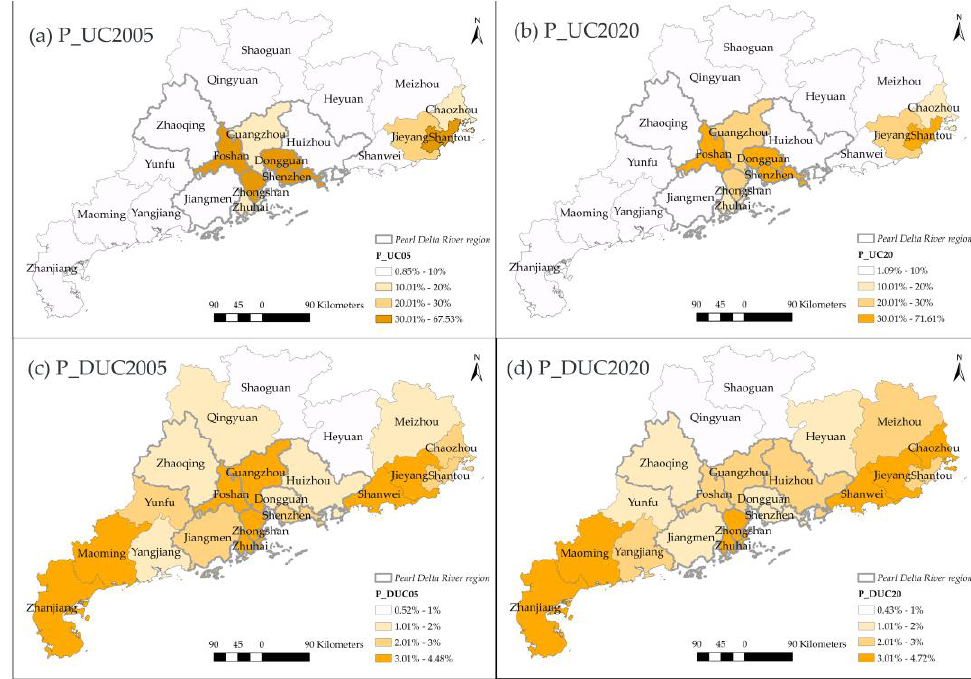
Figure 6. The spatial distribution of P_UC and P_DUC in 2005, 2020.